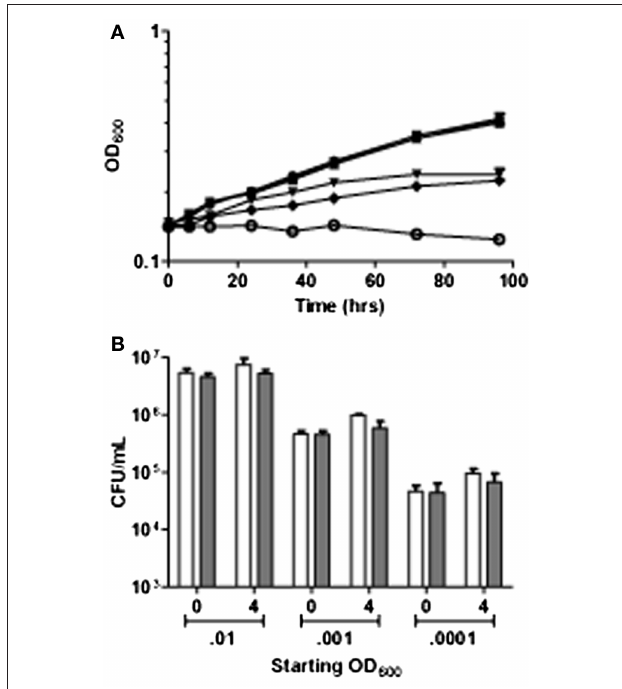
Figure 2 | The effect of NO stress on growth and survival. (A) Growth of Mtb for 96 h post exposure to slow release NO donor DETA/NO. Filled circles, 0.01 N NaOH control; filled squares, 0.005: filled triangles 0.05; filled downward triangles, 0.5; filled diamonds, 1.0; and open circles 5 mM DETA/ NO (B) Survival of Mtb over a range of low starting cell densities (0.01, 0.001, and 0.0001 OD) monitored by colony forming units. White bars indicate 0.01 N NaOH controls and gray bars indicate exposure to 5 mM of the rapid release NO donor spermidine-NONOate Time points were taken before addition of NO donor (0) and after 4 h of exposure to NO